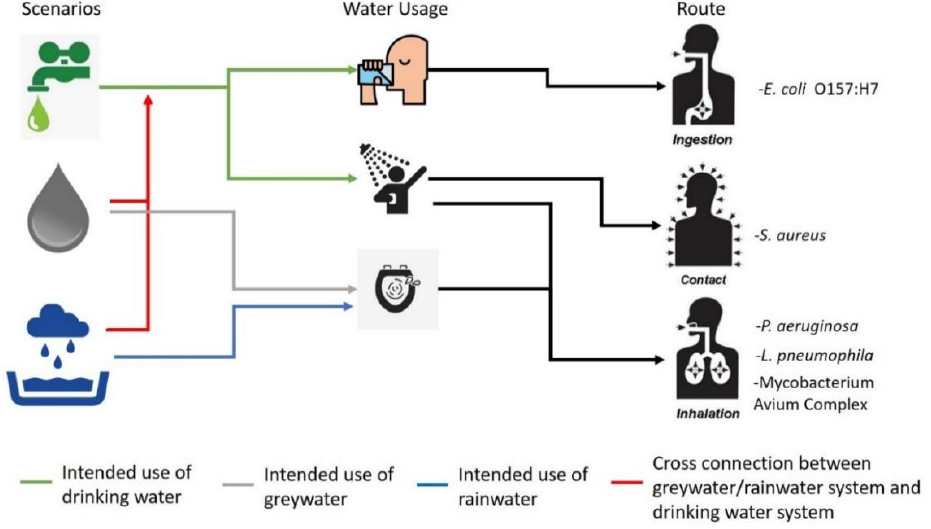
Figure 1. Illustration of exposure routes.